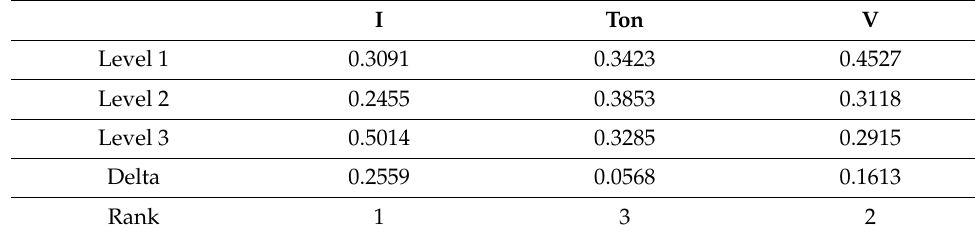
Table 6. Response table for sample B.